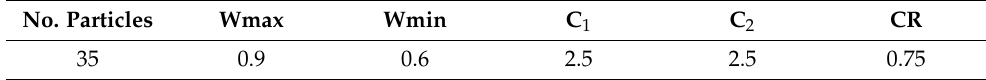
Table 2. The PSO set parameters.